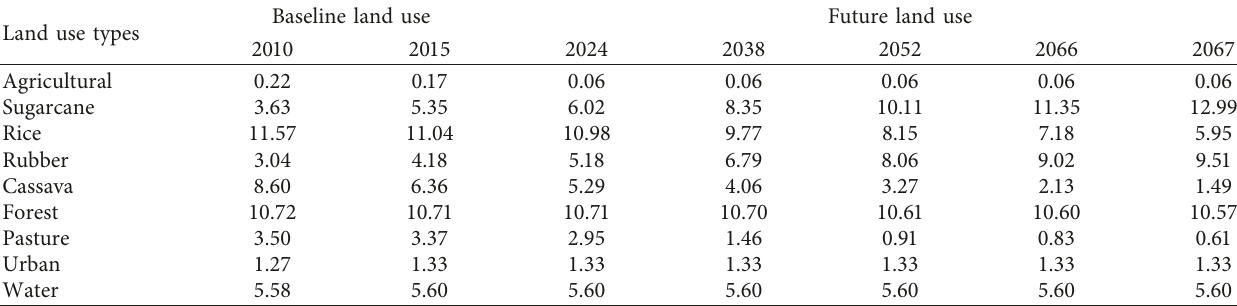
Table 4: Trends of land use change for baseline and future periods above the Huay Sabag area (km 2 ).